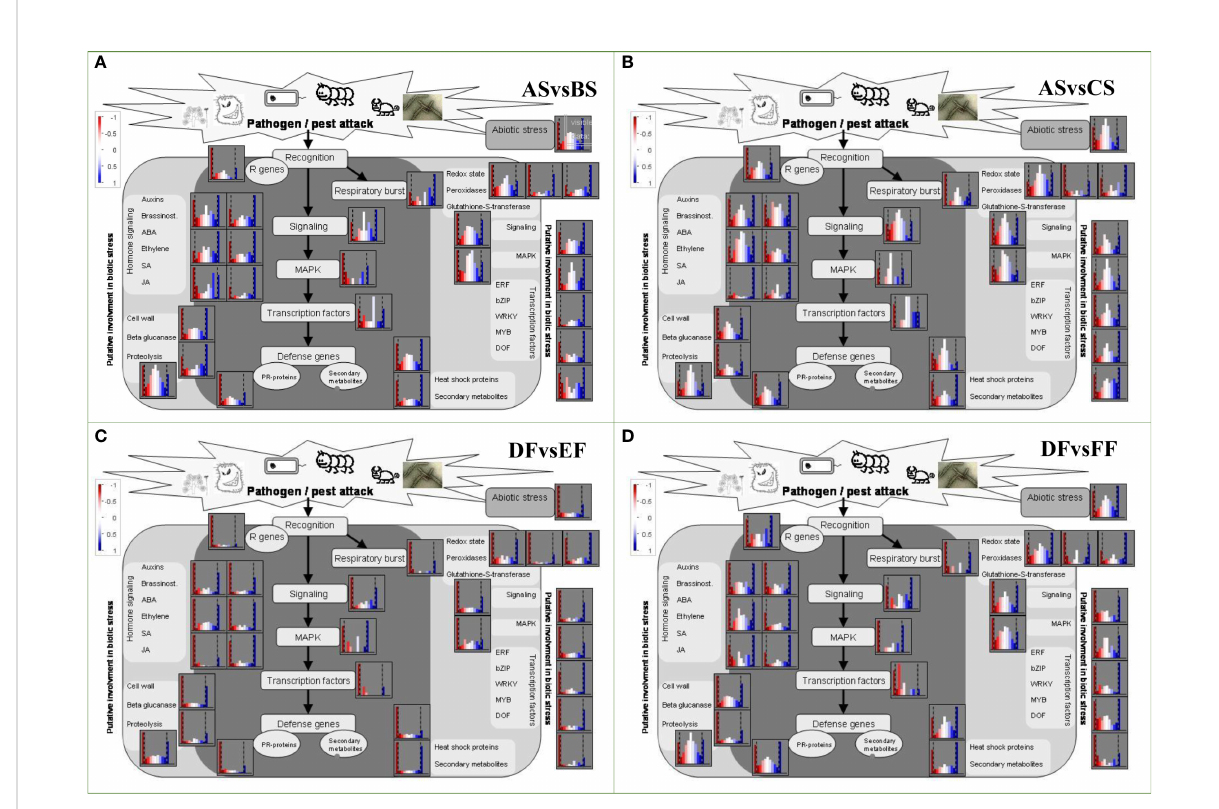
FIGURE 6 DEGs assigned to abiotic stress based on Mapman software. This map consisted of the genes that participated in abiotic stress, redox, signaling, transcription factors, heat shock proteins, pathogenesis protein, hormone relative genes, as well as the genes implicated in cell wall and proteolysis. Blue represents upregulation, while red represents downregulation. (A – D) represent the comparison group of ASvsBS, ASvsCS, DFvsEF, and DFvsFF,